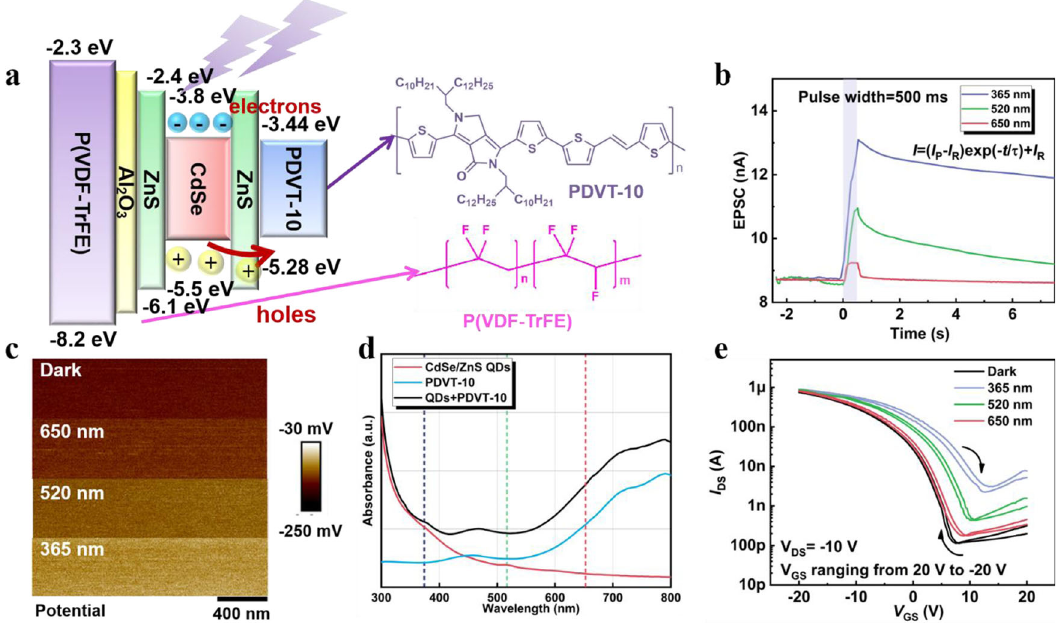
Fig.2|Selectiveattentionofwavelengths.a TheHolesgenerationprocessduring the synaptic behaviors and the chemical structure of P(VDF-TrFE) and PDVT-10. b The excited postsynaptic current triggered by light pulses (1 μ W/cm 2 , 0.5s) with wavelengths of 365nm, 520nm and 650nm. c Surface potential of PDVT-10/QDs